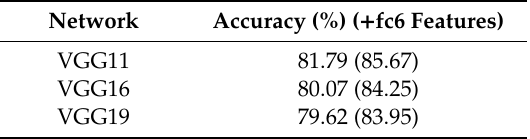
Table 5. Performance of di ff erent backbone networks on MIT indoor 67 dataset.